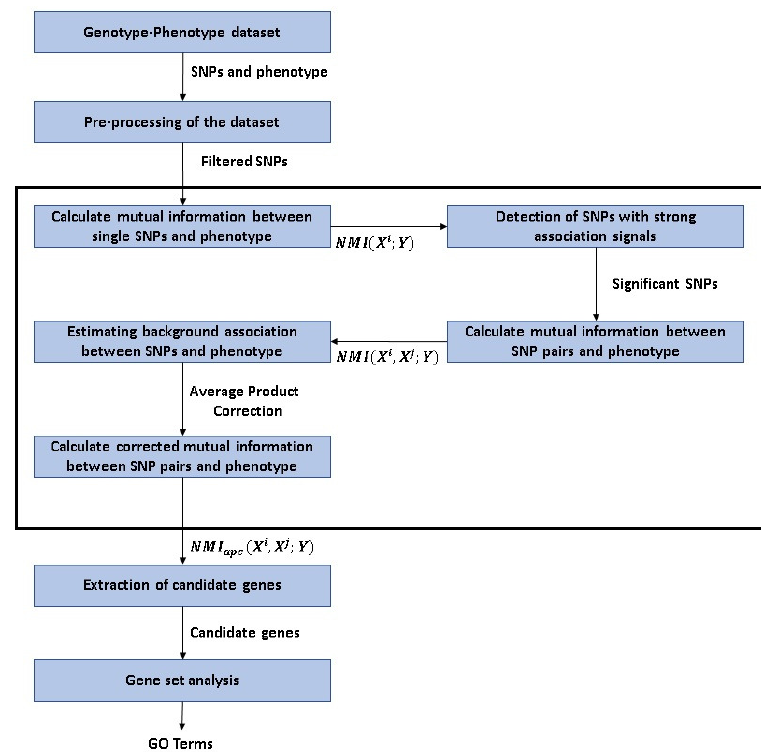
Figure 1. Flowchart of the analysis applied in this